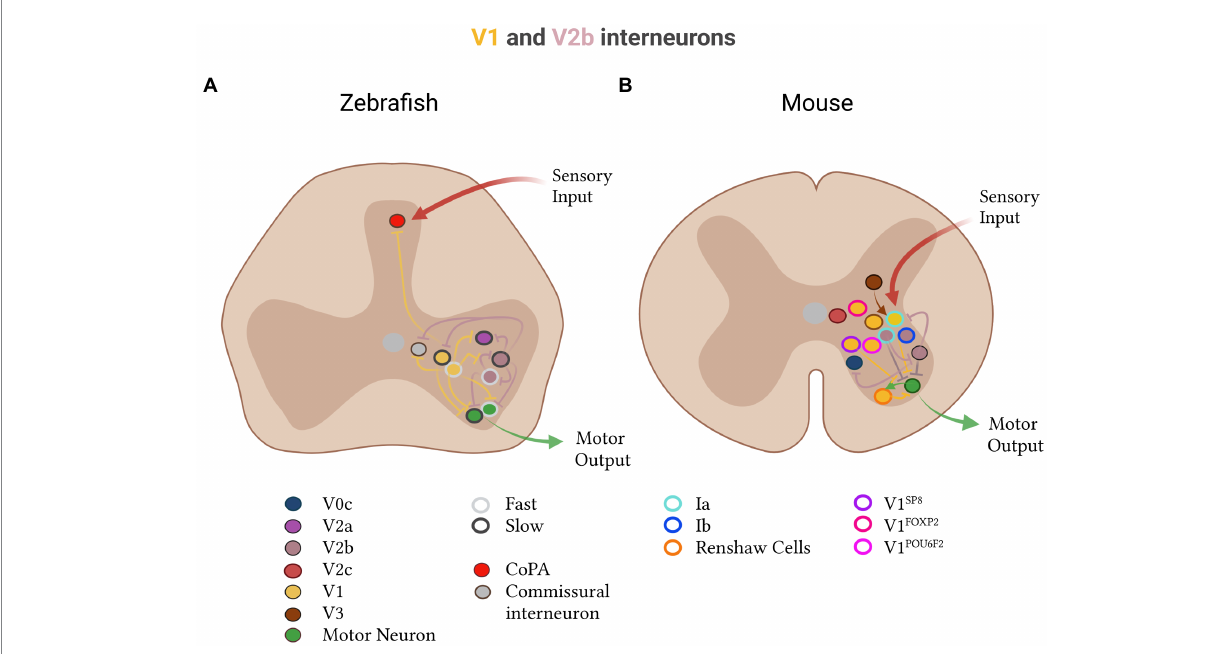
FIGURE 5 Inhibitory V1 and V2b subtypes in zebrafish and mice. (A) In zebrafish, V1 (yellow) and V2b (brown) divide into fast (light gray, outline) and slow (dark gray, outline) subtypes. V1 neurons: The fast V1 subgroup (yellow, light gray outline) inhibits both slow (green, dark gray outline) and fast (green, light gray outline) motor neurons in addition to slow-type V2a neurons (pink, dark gray outline). The slow V1 subgroup (yellow, dark gray outline) inhibits slow motor neurons (green, dark gray outline). V1 neurons also project to dorsal CoPA neurons (red) which receive sensory input, V2a neurons (pink), V2b neurons (brown), and commissural neurons (gray). V2b neurons: Slow V2b neurons (brown, dark gray outline) inhibit fast motor and other V2b neurons. Fast V2b neurons (brown, light gray outline) inhibit slow motor and other V2b neurons. V2b neurons in zebrafish also project to V2a, V1 and commissural neurons. (B) In mice, V1 neurons and subdivide into Ia-interneurons (light blue, outline), which receive sensory input and inhibit motor output; Renshaw cells (orange outline) which form recurrent connections with motor neurons; and four clades: Sp8 (purple outline), FoxP2 (pink-red outline) and Pou6f2 (pink outline). V1 neurons also receive input from V3 neurons (brown). V2b neurons include Ia- and Ib- (dark blue, outline) interneurons. V2b-derived Ia-interneurons inhibit motor and other V2b neurons. V2b neurons also inhibit V0c neurons. An additional V2c class is present in mice (red-pink) with an unknown projection